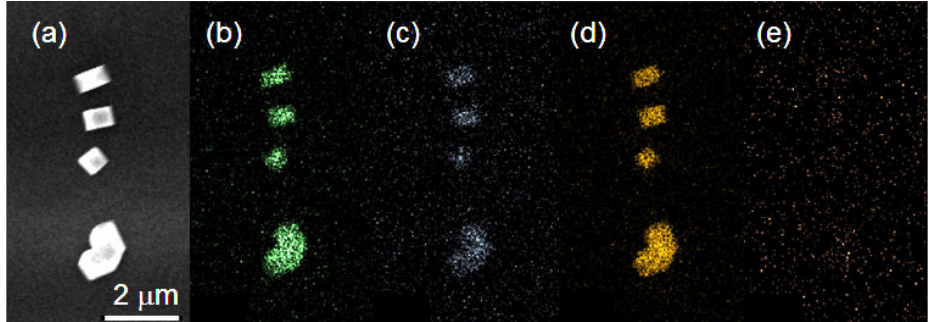
Figure 4. (Color online) Investigation of the constituent elements in the In-SnTe nanostructures grown by vapor transport on a Si substrate under the vapor-solid (V–S) mechanism without GNPs and energy dispersive X-ray (EDX) spectroscopy mapping of In-SnTe nanostructures grown under the V–S mechanism without GNPs. ( a ) SEM topography. ( b – e ) EDX spectroscopy elemental mappings for ( b ) Sn, ( c ) In, ( d ) Te, and ( e ) Au of the nanostructures in ( a ). Scale bar in ( a ) is 2 µ